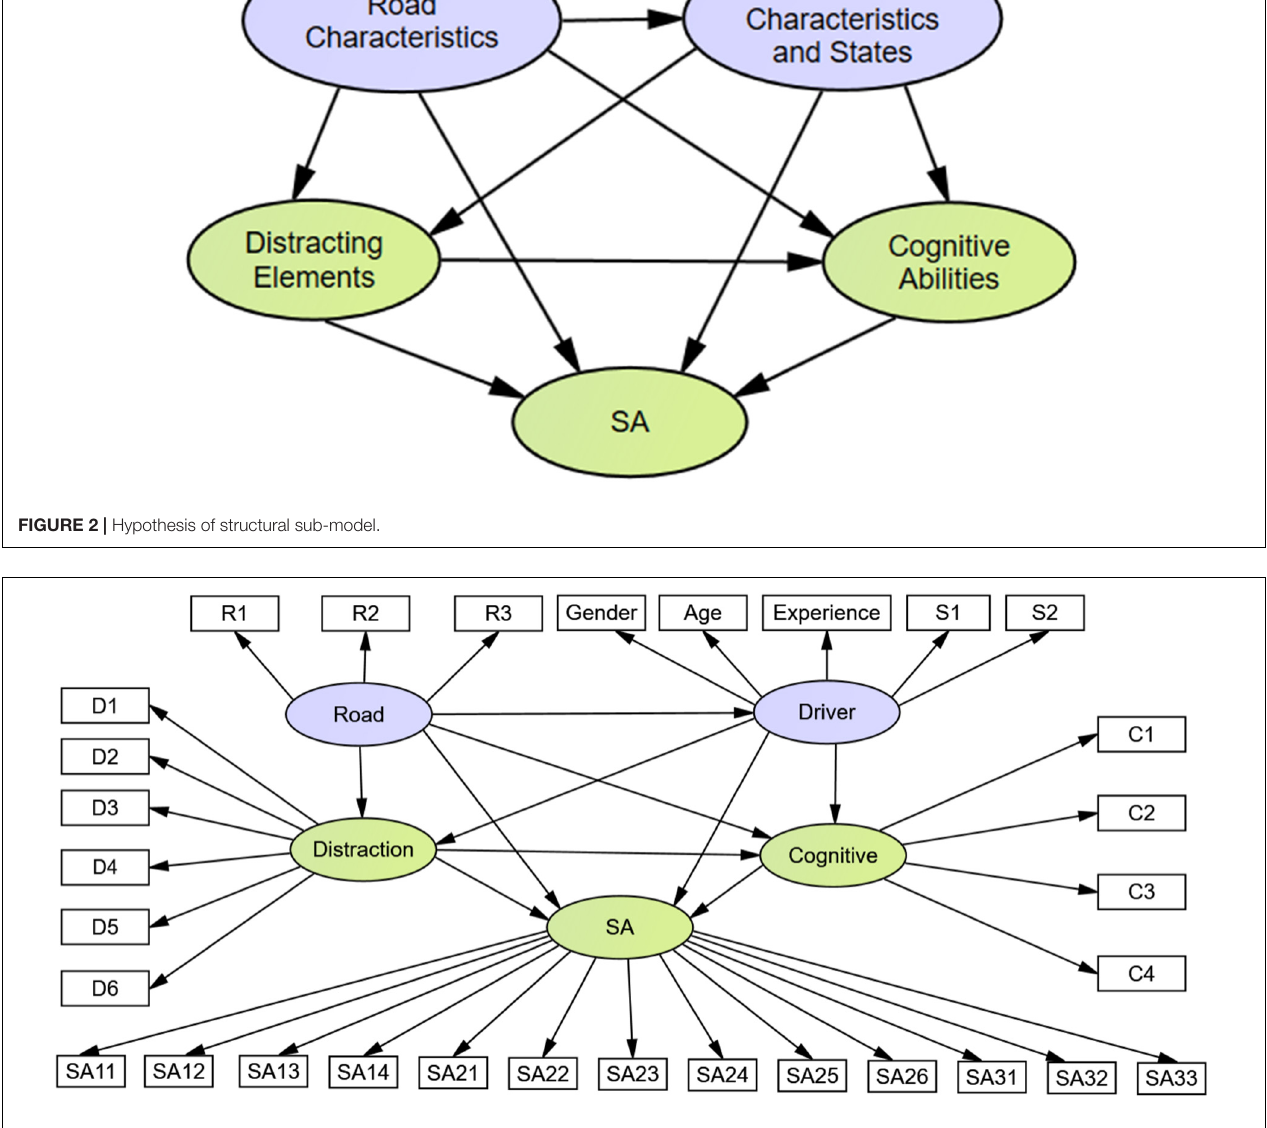
FIGURE 3 | Path of structural equation